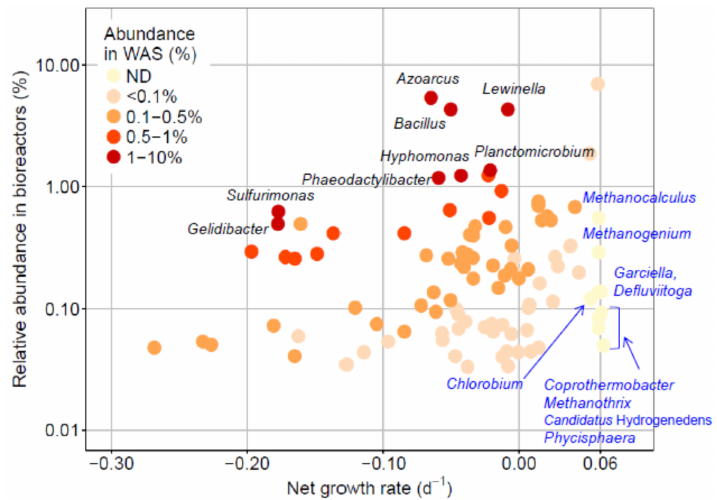
Figure 5. Mean relative abundance of identified genera in the bioreactors and the estimated net growth rate. Taxa > 1% in the waste activated sludge (WAS; influent) are labelled in black, whereas taxa that were not detected in the WAS are labelled in blue.